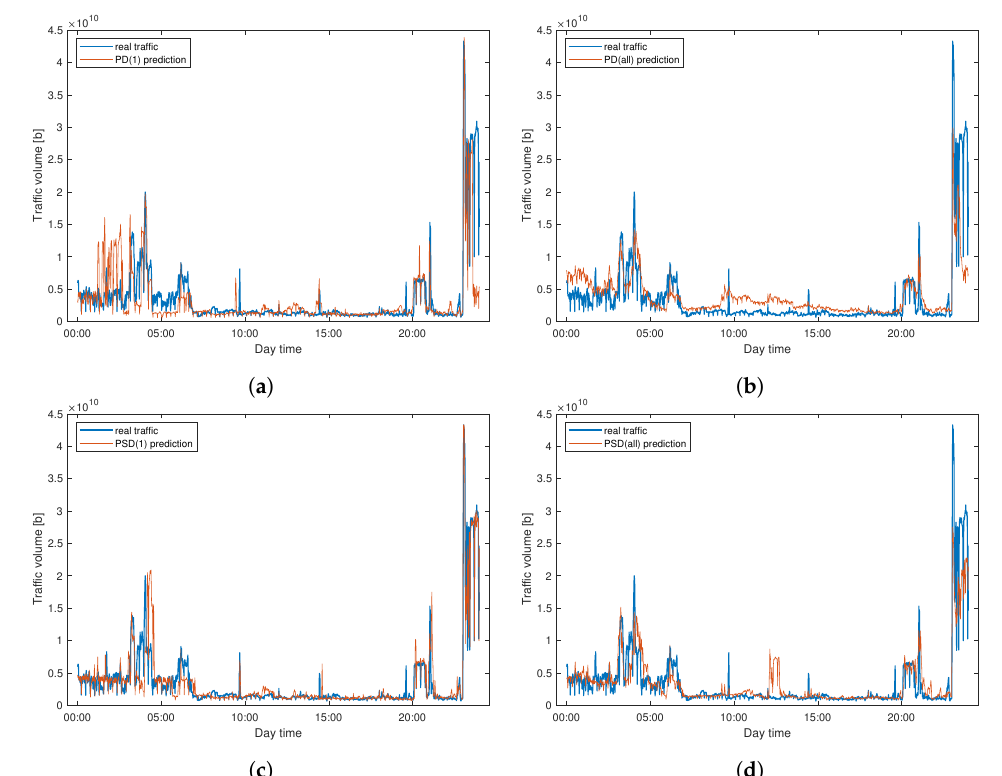
Figure 11. Efficiency of modeling-based prediction for WASK dataset—observed and predicted traffic as a time function. ( a ) PD (1) method, ( b ) PD (all) method, ( c ) PSD (1) method, ( d ) PSD (all) method.